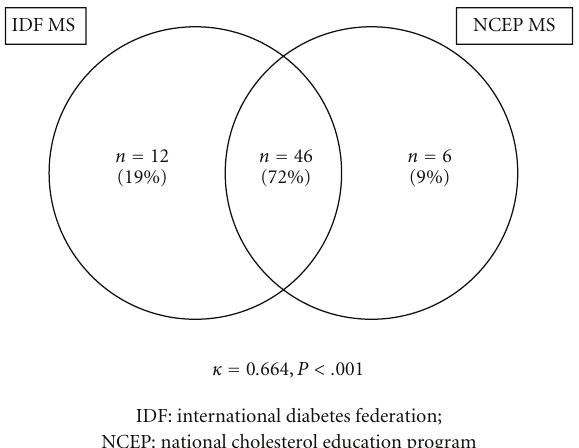
Figure 1: Prevalence of the metabolic syndrome according to di ff erent